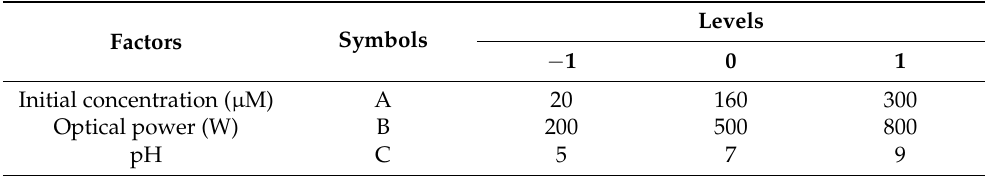
Table 1. Experimental factors and their levels.